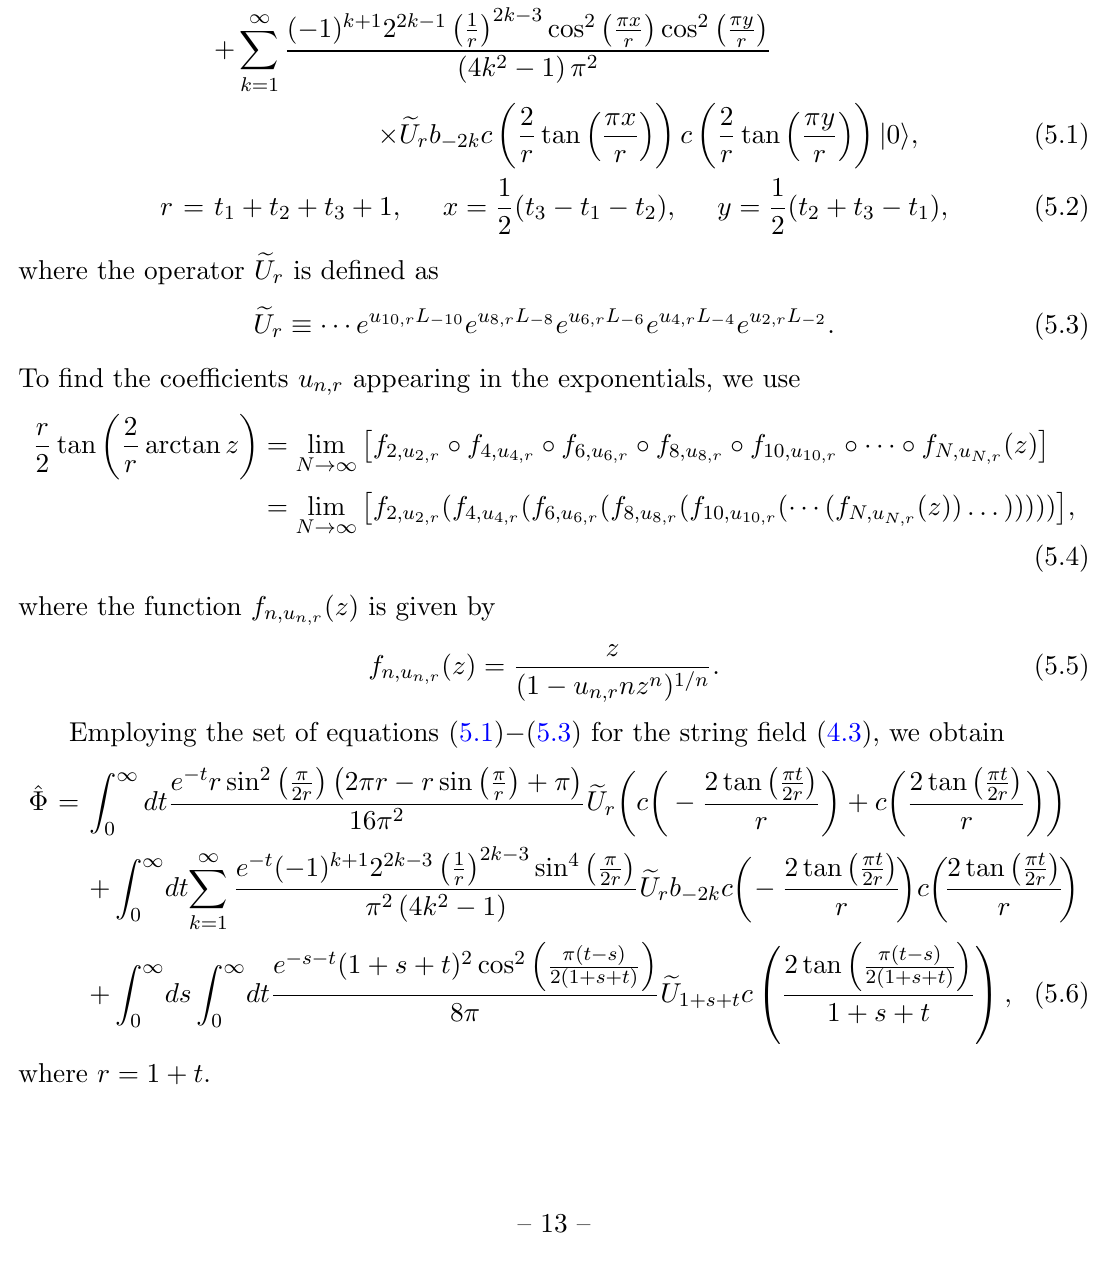
Pad(cid:19)e-Borel approximation. In the n